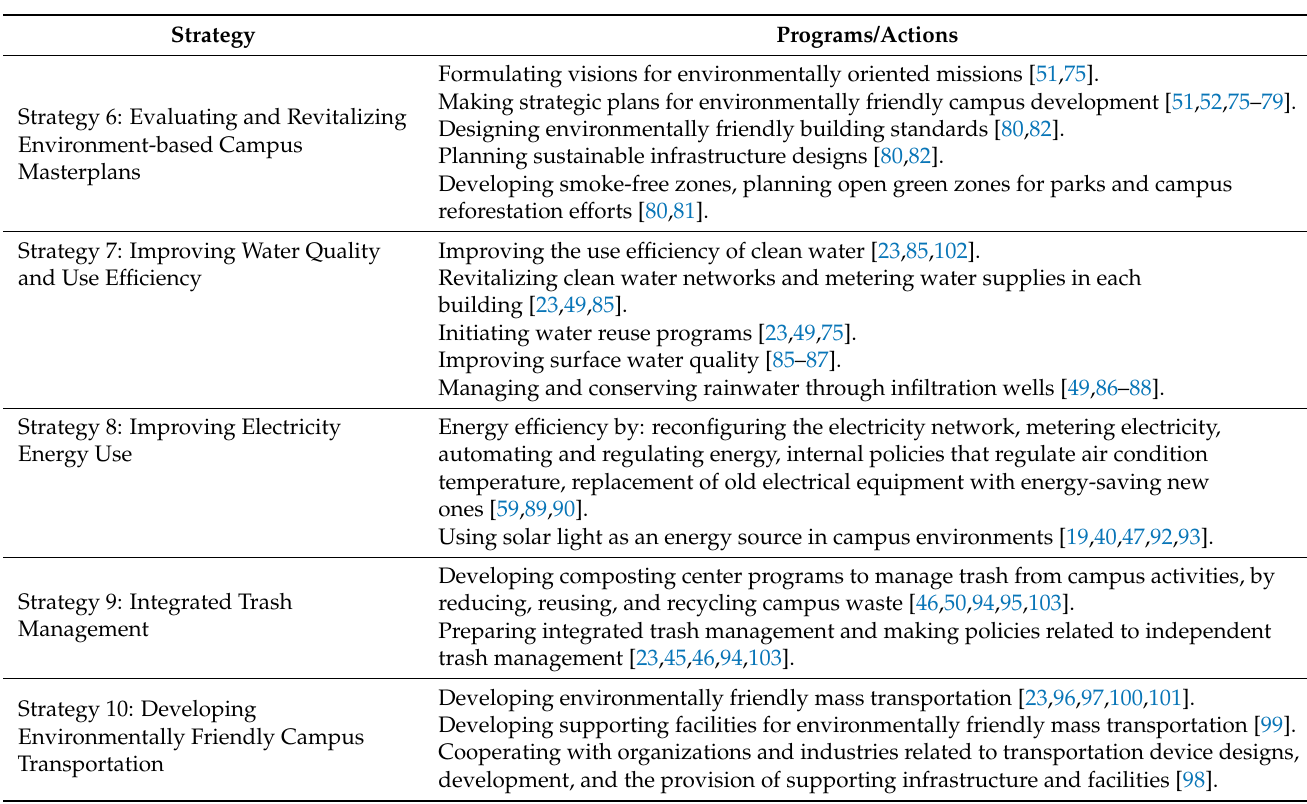
Table 3. Strategies in the physical facility